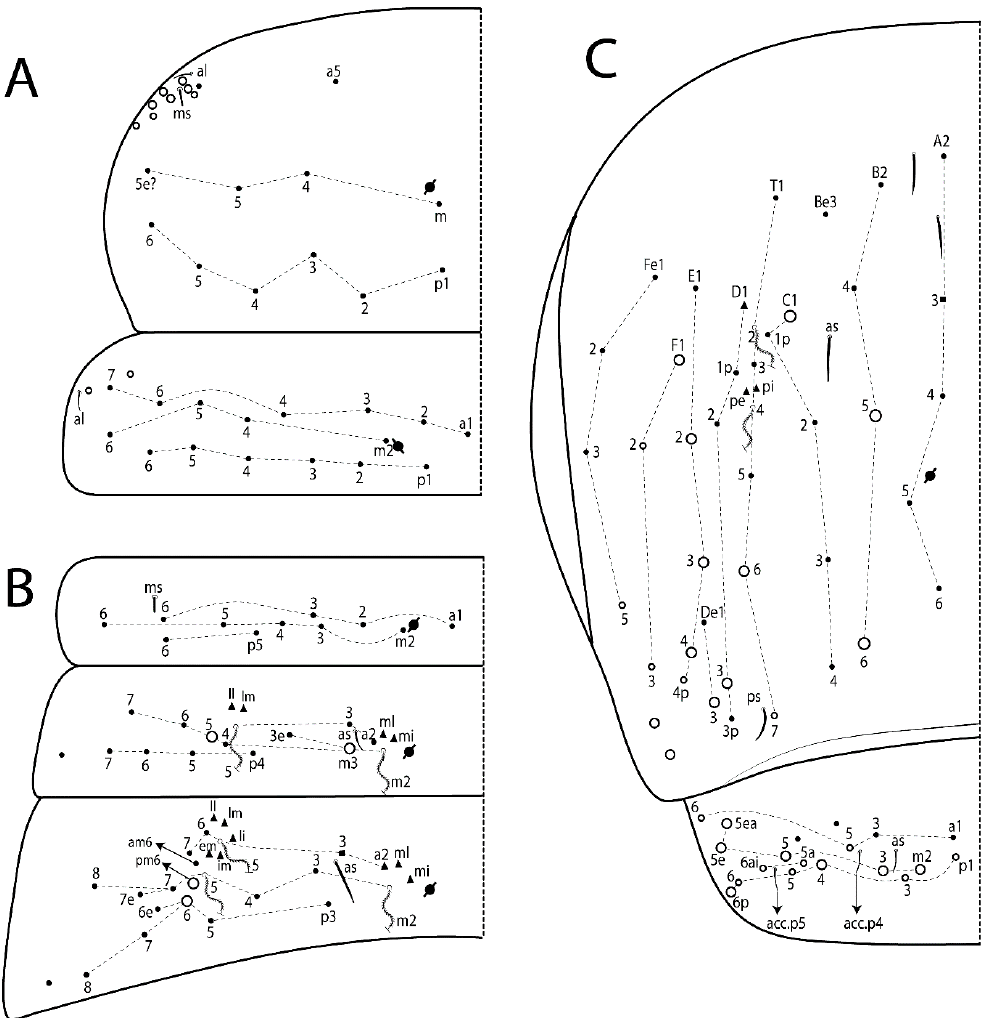
Figure 29. Pseudosinella serpentinensis sp. nov.: dorsal chaetotaxy. ( A ) Th II–III; ( B ) Abd I–III; ( C ) Abd IV–V.